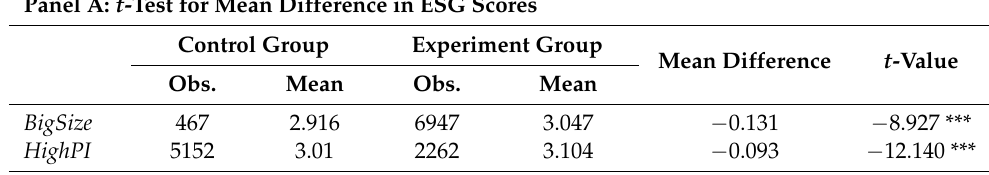
Table 3. Empirical results of the moderating effects model. Panel A: t -Test for Mean Difference in ESG Scores